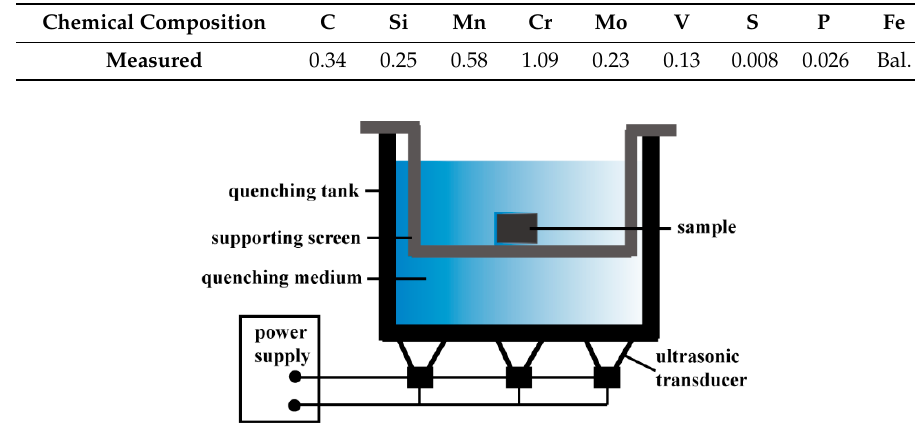
Figure 1. Schematic diagram of quenching. Table 1. Composition of 35CrMoV steel (wt %).